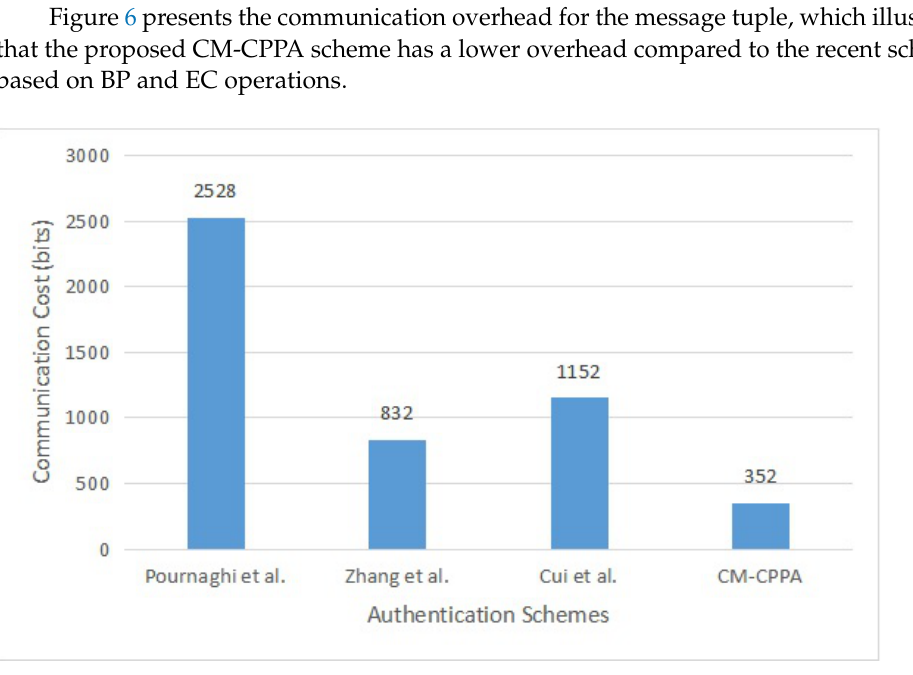
Figure 6. Communication Overhead for Message